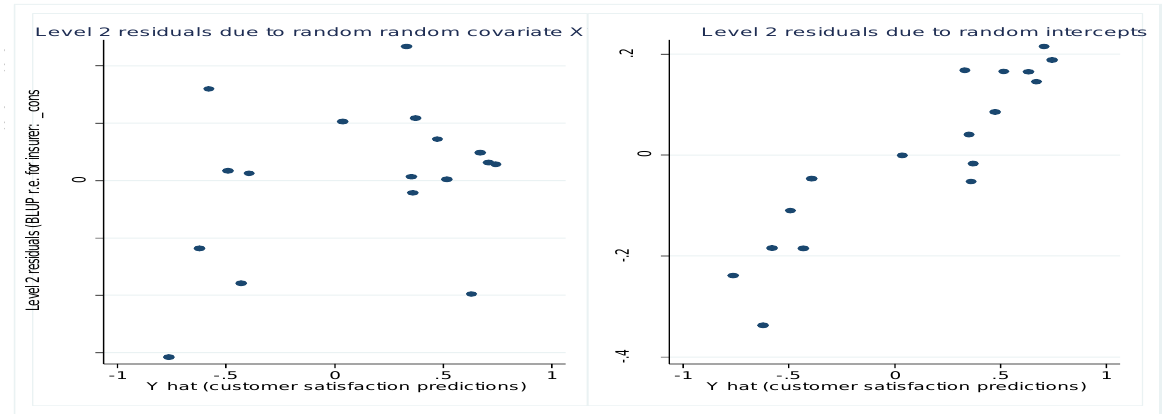
Figure 9: Scatter plot of residuals against predicted values for level-2 residuals; Assurance Customer satisfaction model